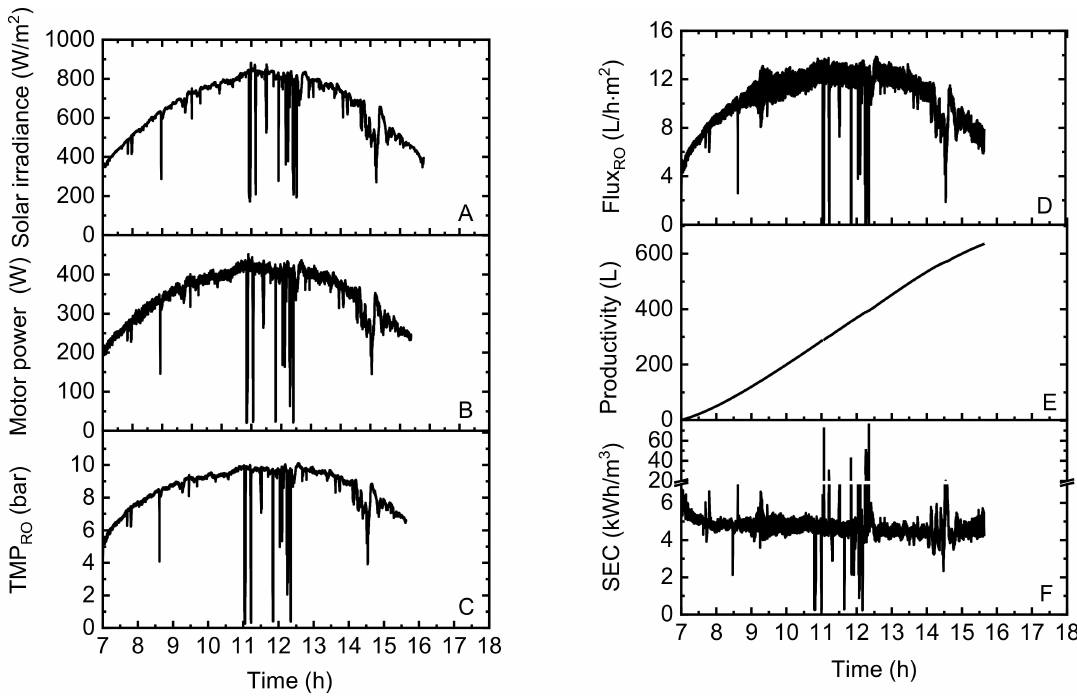
Figure A6. The directly coupled PV-membrane system performance on the “partly cloudy day” without SCs, indicating ( A ) the solar irradiance, ( B ) motor power, ( C ) TMP RO , ( D ) Flux RO , ( E ) production and ( F ) SEC.